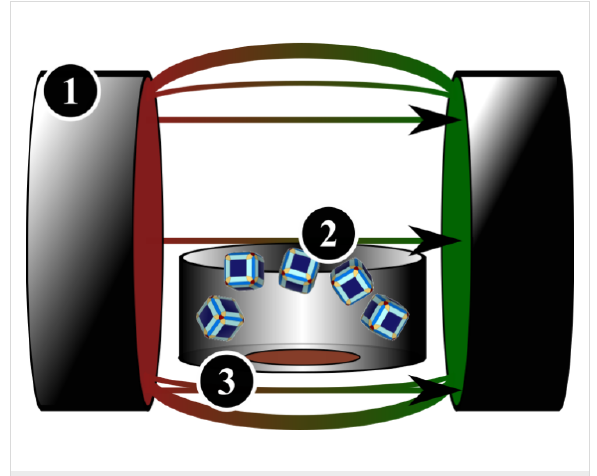
Figure 1: Schematic illustration of the experimental set-up to produce directed mesocrystals. A nanocrystal dispersion (2) was left to dry on top of a TEM grid (3) within an applied homogeneous magnetic field (1). The arrows indicate the direction of an applied external magnetic